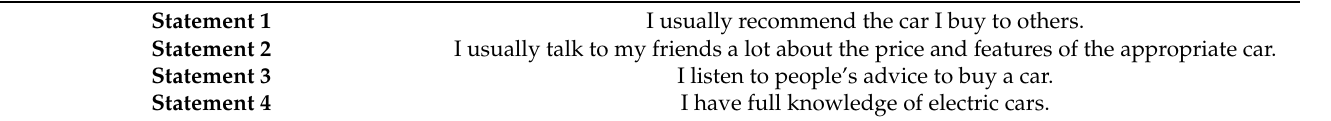
Table 6. The statements reveal respondents’ social